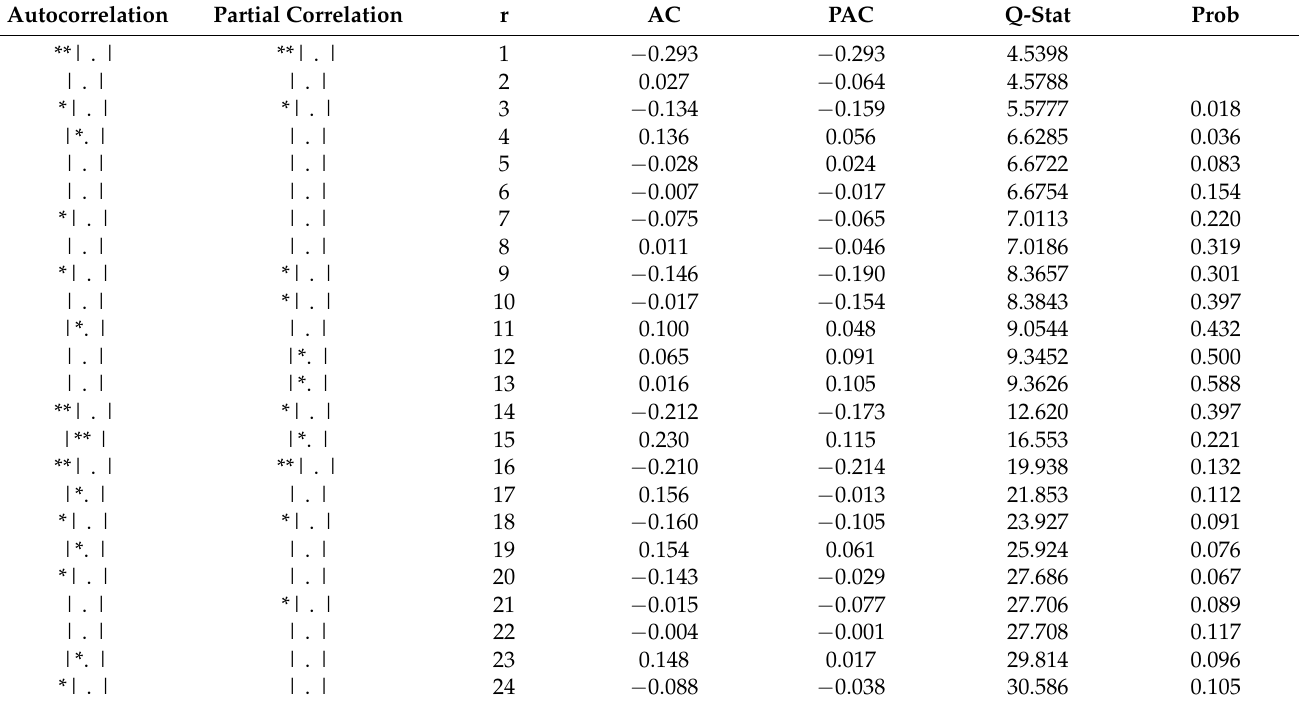
Table 9. Statistical analysis of Ljung-Box.